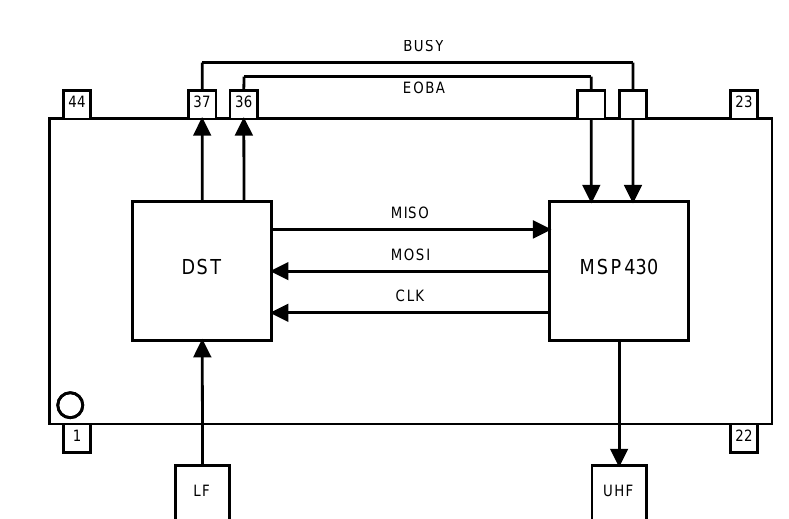
Figure 7: A schematic overview of the TMS37F128 package with the DST co-processor and MSP430 microcontroller. During nominal operation a challenge is receiver over LF and communicated to the MSP430 using the EOBA pin. Afterwards, the microcontroller sends it to the transponder over SPI after which it transmits the returned response over